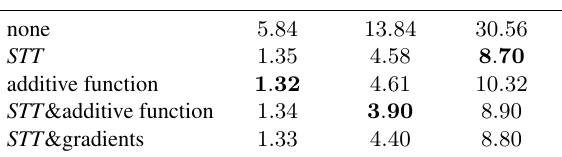
Table 3: AEP of the TV-L1 algorithm using different illumination models. (unit: pixel=m)